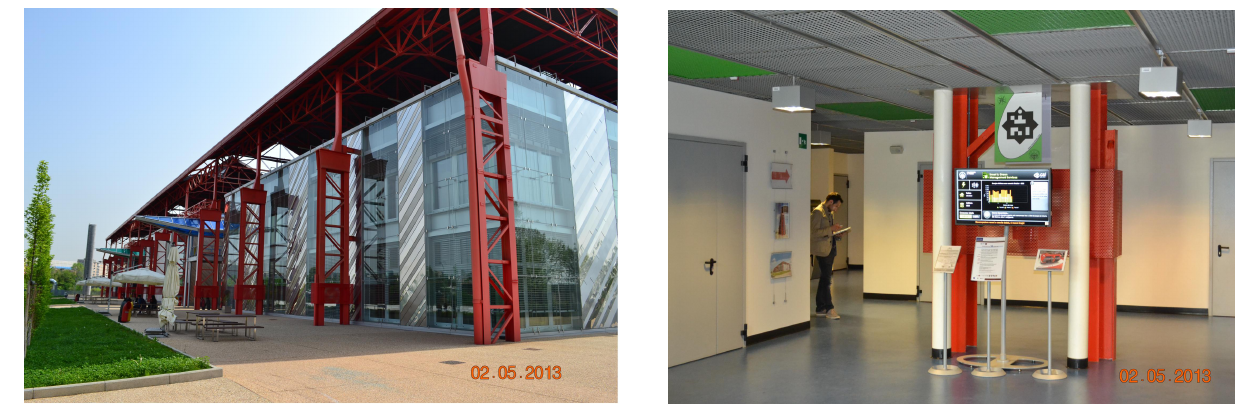
Figure 9. Monitored building in Torino, Mirafiori,